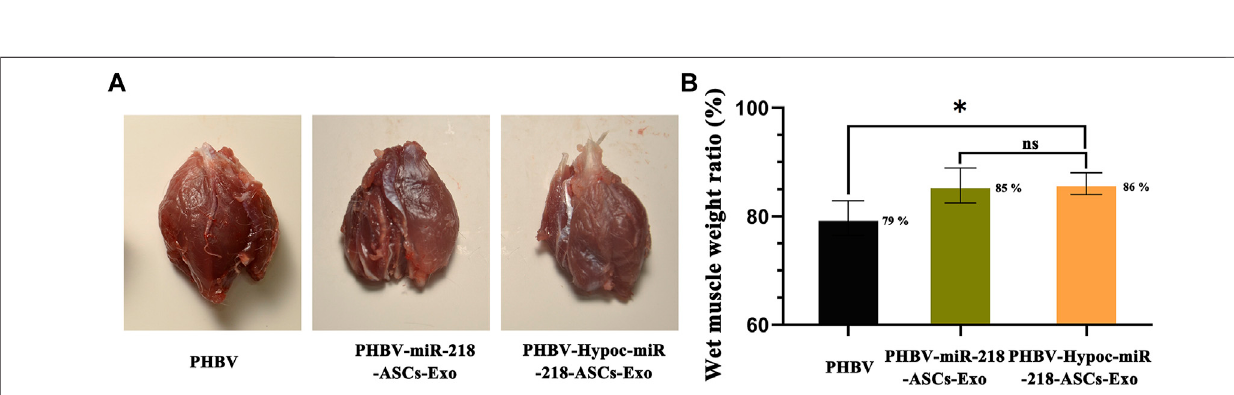
FIGURE 11 | SFI of sole PHBV scaffold (PHBV group), scaffold combined with miR-218-ASCs exosomes (PHBV-miR-218-ASCs-Exo group), and scaffold combined with Hypoc-miR-218-ASCs exosomes (PHBV-Hypoc-miR-218-ASCs-Exo group) were tested after animal surgical procedures. (A) Footprints of three groups (scale bars = 2 mm). (B) SFI values of three groups.